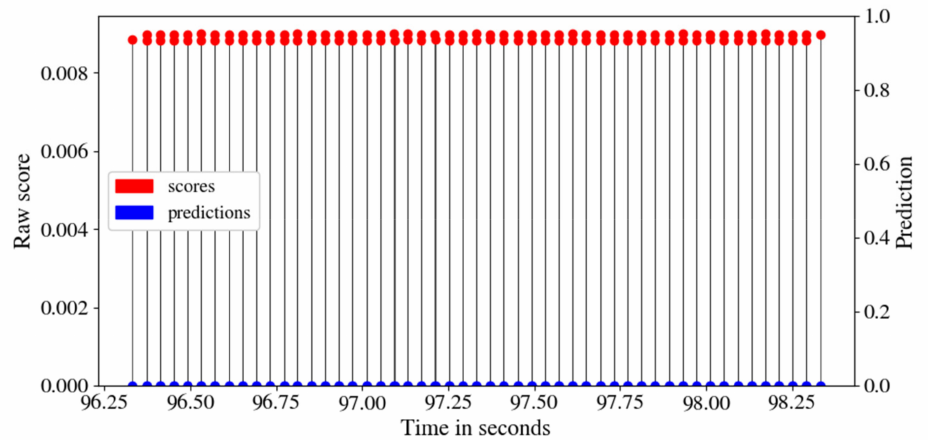
Figure 10. OC-SVM predictions and raw scores of the anomaly-based NIDS for a baseline net- work traffic.